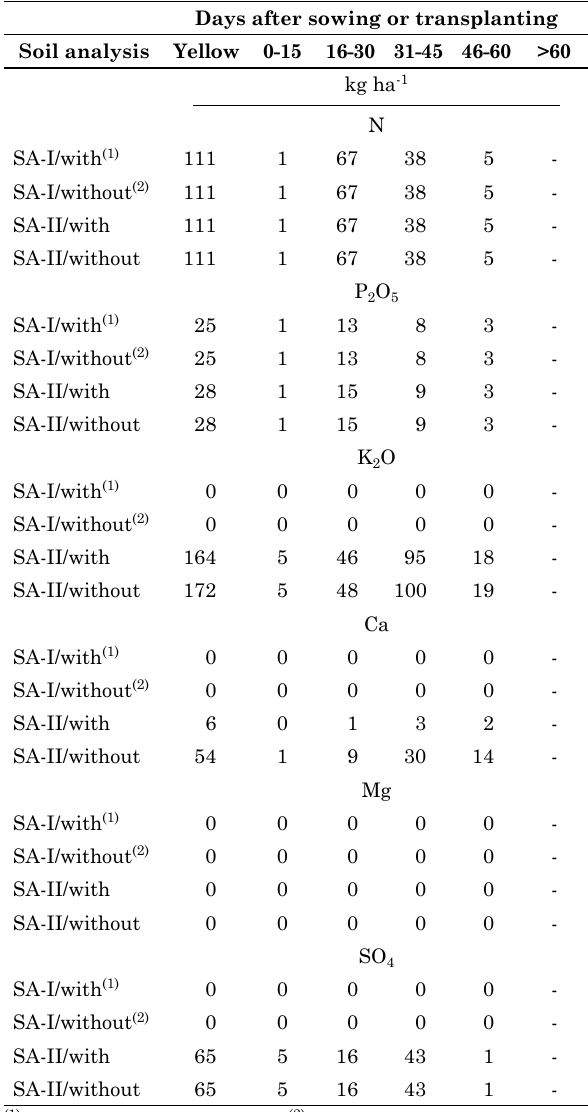
for nutrient distribution in topdressing (fertigation) for Yellow type considering a yield of 45 t ha -1 Days after sowing or